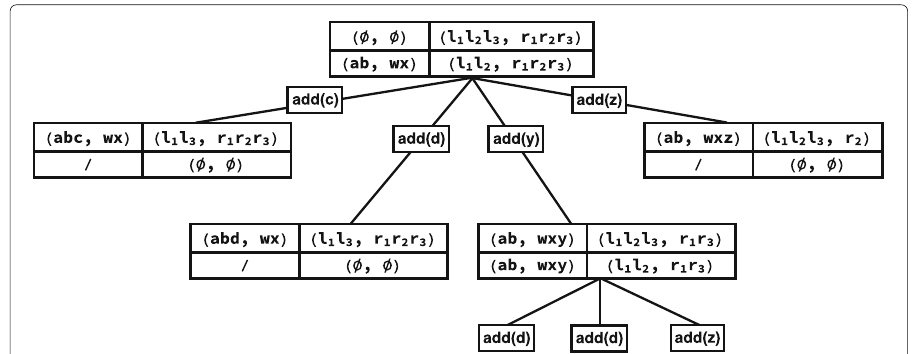
Fig. 4 The search tree developed by minerLC during the bi-pattern enumeration of Example 4. Each box represents on the first line a bi-pattern q together with its support set pair e in the current vertex set, and on the second line the core p ( e ) of the subgraph induced by this support set pair, preceded by the associated abstract closed bi-pattern int ◦ p ( e ) . In the top box q is the empty bi-pattern, and its successors are obtained by adding an item to the abstract bi-pattern of the top box. In all leaves the core p ( e ) is